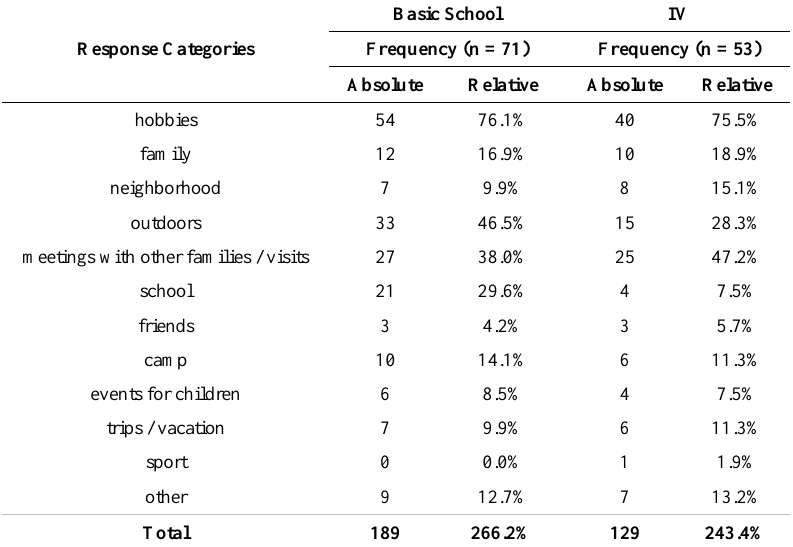
Response Categories